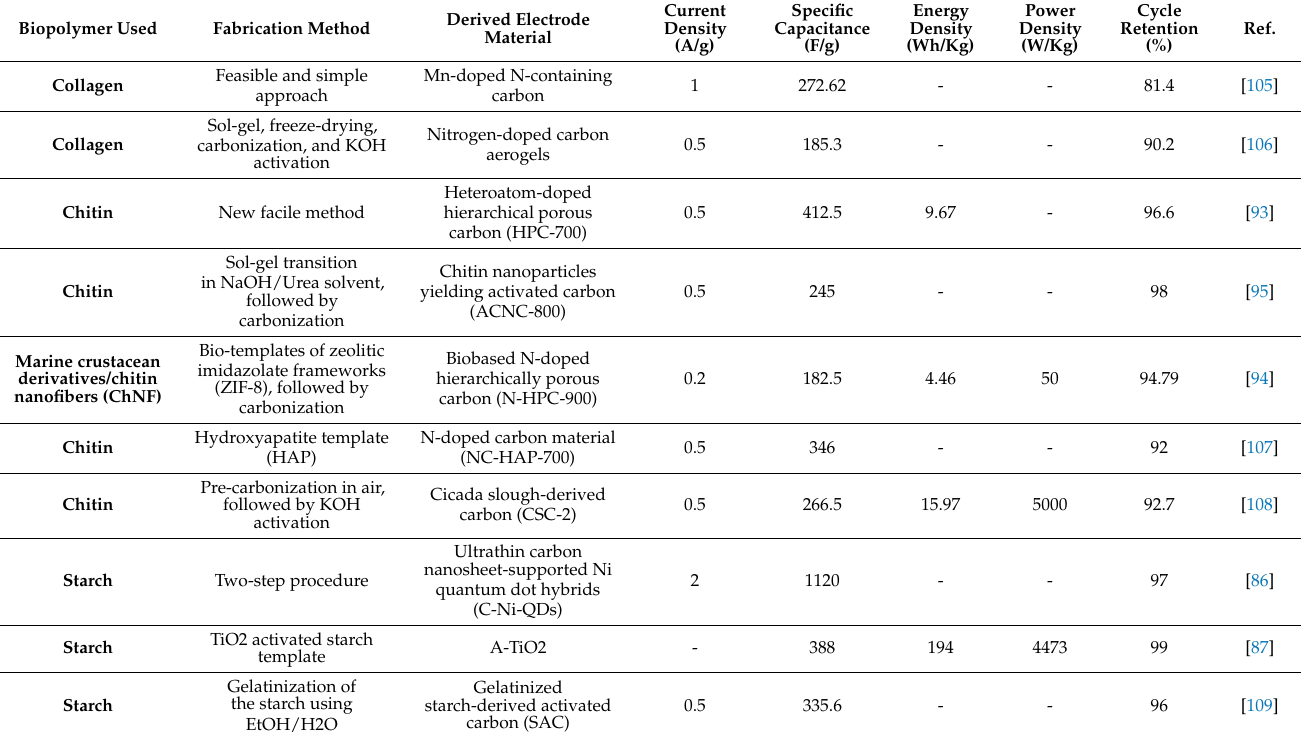
Table 2. Electrochemical performance evaluation of some biopolymeric synthesized electrode